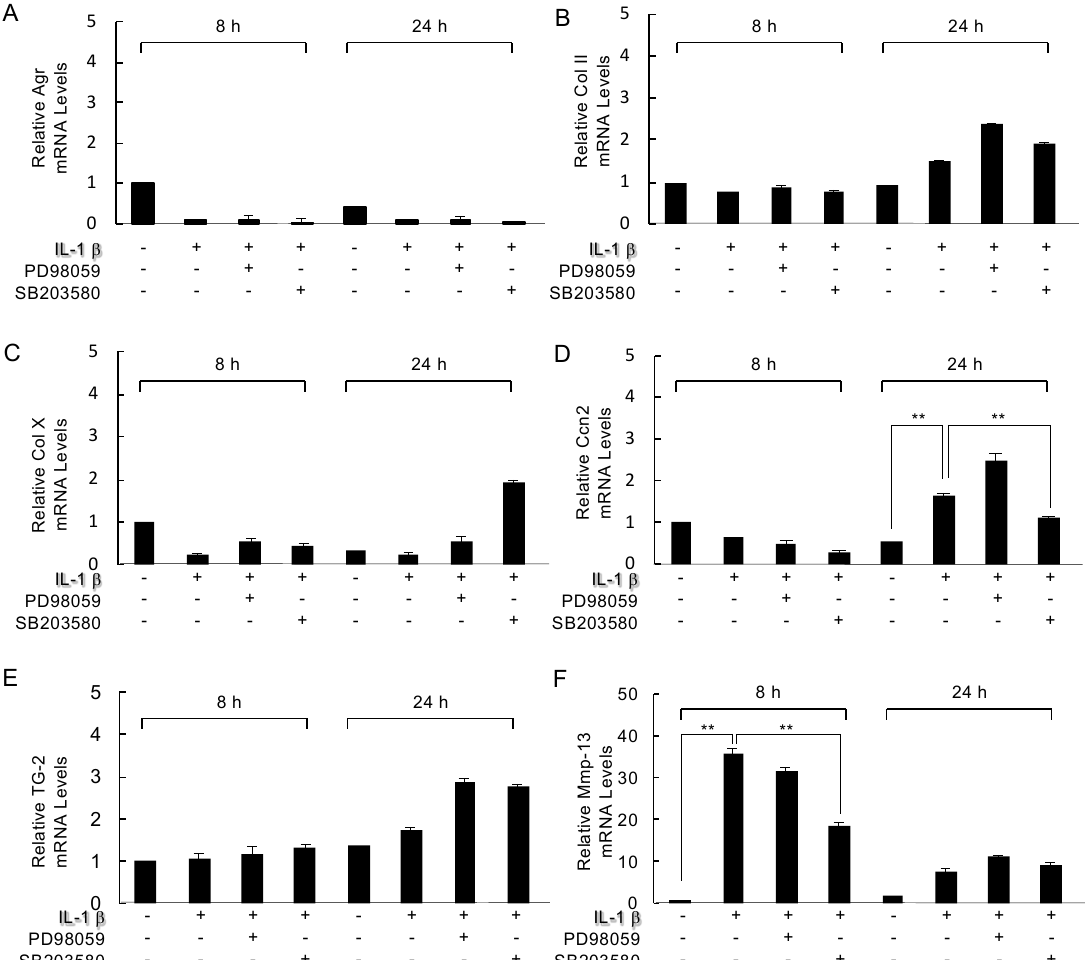
01020304050 Figure 5. Analysis of the actions of the RAR inverse agonist AGN194310 and mitogen-activated protein kinase (MAPK) on e ff ect of PD98059 or SB203580 on the IL-1 β modulated genes. IL-1 β -induced Agr, Col2, Col10, Ccn2 mRNA, Tg2, and Mmp13 mRNA. ATDC5 cells were exposed to 10 ng / mL IL-1 β with / without 100 nM RAR inverse agonist AGN194310 for the indicated times, and the cell lysates were processed for an immunoblot determination of phosphorylated extracellular signal regulated-kinase (pERK1 / 2) and p-p38 MAPK ( A ), and phosphorylated activating transcription factor 2 (p-ATF2) ( B ). ERK1 / 2, p38 MAPK, and ATF2 was used as reference to quantify protein bands of pERK1 / 2 p-p38 MAPK and p-ATF2 by densitometry using ImageJ software individually. C: The level of activated p38 MAPK activity was determined by a kinase activity assay. ATDC5 cells were treated with 10 ng / mL IL-1 β with or without 20 µ M ERK1 / 2 kinase inhibitor PD98059 or p38 MAPK SB203580 for 24 h. Total RNA from these cells was used in a real-time RT-PCR analysis for aggrecan ( A ), Col II ( B ), Col10 ( C ), Ccn2 ( D ), Tg2 ( E ), and Mmp13 ( F ). The values in the graph indicate the relative mRNA level of the fold changes. The data from a typical experiment are presented; similar results were obtained in three separate experiments. Columns and S.D. bars, mean of triplicate determinations. Statistically significant di ff erences (** p < 0.01) between the indicated groups are marked by